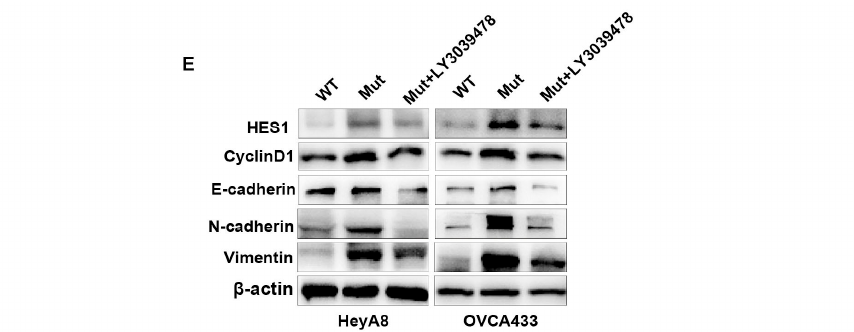
Figure 2. NOTCH1 -p.C720fs mutation promotes epithelial-mesenchymal transition (EMT) and could be controlled by a NOTCH1 inhibitor in ovarian cancer cells. HeyA8 and OVCA433 cells were selected for the function of NOTCH1 - p.C720fs mutation because of low expression of NOTCH1. An empty vector or that with the NOTCH1 mutation were infected to HeyA8 and OVCA433 cells. HeyA8 and OVCA433 cells with wild-type and mutated Notch1 were pretreated with vehicle, 1 µ M and 2 µ M LY3039478 for 24 h, then subjected to transwell and wound healing assay to evaluate NOTCH1 -p.C720fs mutation on migration and the efficacy of NOTCH inhibitor LY3039478. ( A ) The expression level of NOTCH1 NTM in nine ovarian cancer cell lines. ( B ) The expression of flag tag confirmed that HeyA8 and OVCA433 cells stably harbored NOTCH1 -p.C720fs mutation by Western blot. ( C – E ) NOTCH1 -p.C720fs mutation significantly enhances migratory ability, LY3039478 could inhibit migration in cells with wild-type and mutated NOTCH1 on the dependence of dose, and the inhibitory efficacy was more remarkable in cells with mutated NOTCH1. Migratory ability was analyzed by the transwell ( C ) and wound healing ( D ) assay, and the quantitative analysis of the migrated cells was showed on the left. ( E ) The expression of EMT and proliferation pathway related molecules showed corresponding change when the cells were pretreated with 2 µ M of LY3039478. * p < 0.05, ** p <